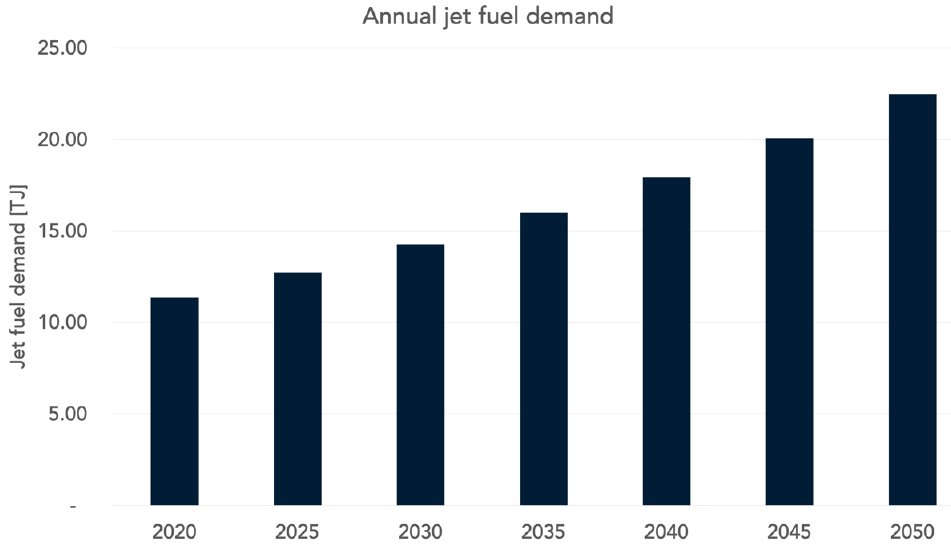
Figure 6. Estimation of annual jet fuel demand in Sweden (2020 – 2050).